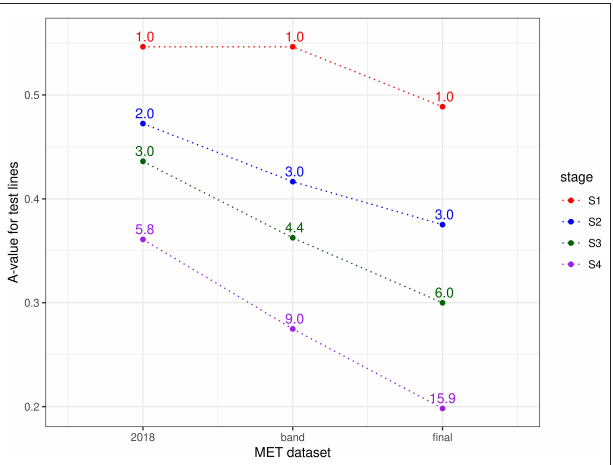
FIGURE 2 | A-values for lines under consideration for selection in durum breeding program in 2018 (stage S4: 56 lines, S3: 93 lines, S2: 315 lines, and S1: 1148 lines). A-values are given for three types of MET dataset, namely 2018 data for each stage; diagonal band of data for each stage and the final dataset constructed as in section 3.1. The points are labeled with the associated mean numbers of environments in which these lines were grown. Note that for S1 the 2018 and band datasets are the